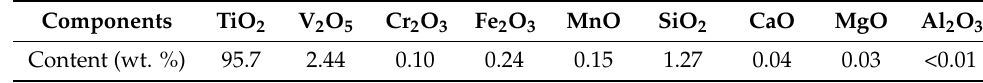
Table 4. Composition of the TiO 2 product in previous study